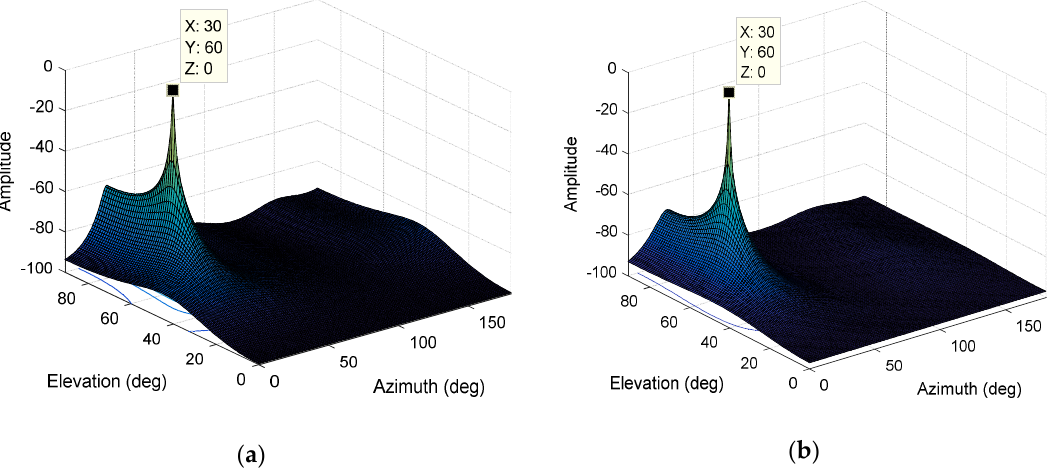
Figure 9. The normalized spectral function. ( a ) The normalized spectral function derived from the MUSIC algorithm ( M = 4, K = 2); ( b ) The normalized spectral function derived from the STC-MUSIC algorithm ( M = 4, L = 4, K = 2).